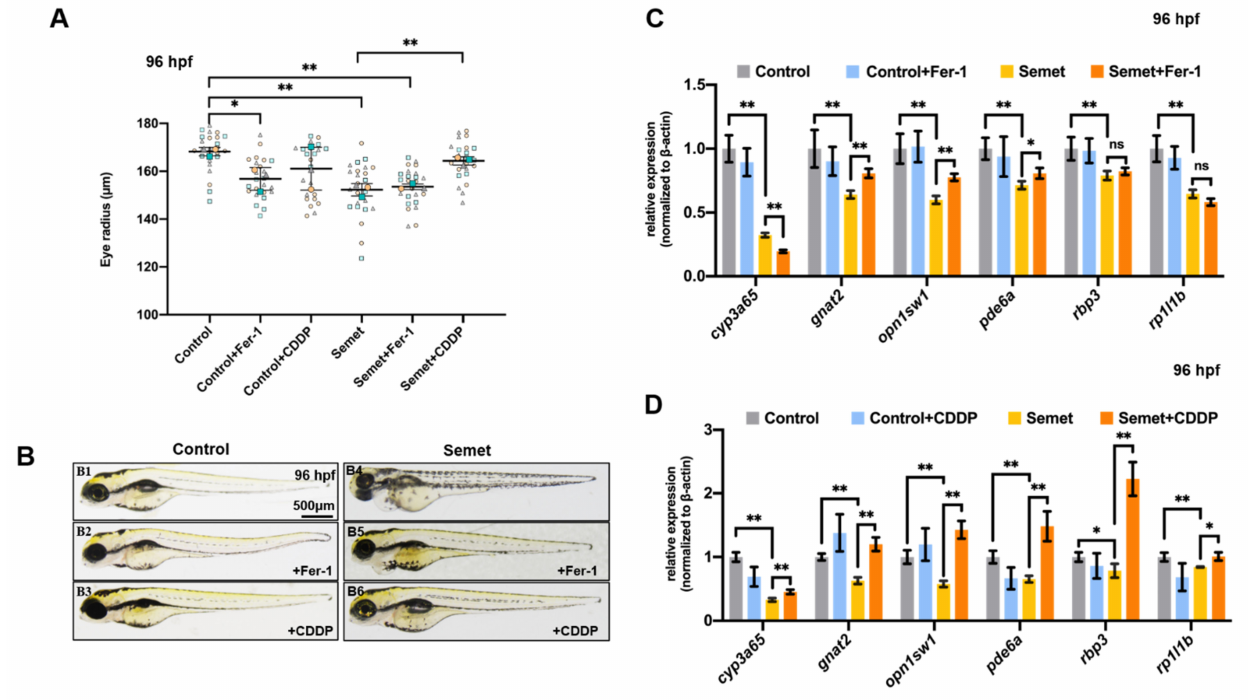
Figure 6. Effect of ocular defects with addition of ferroptosis inhibitor Fer-1 and activator CDDP. ( A ) Measurement of eye radius of embryos from control, semet, semet plus Fer-1 and semet plus CDDP groups at 96 hpf. ( B ) Phenotypes of representative control, semet, semet plus Fer-1 and semet plus CDDP groups at 96 hpf. ( C ) The expression of eye marker genes in control, semet and semet plus Fer-1 groups at 96 hpf. ( D ) The expression of eye marker genes in control, semet and semet plus CDDP groups at 96 hpf. **, P < 0.01; *, P <